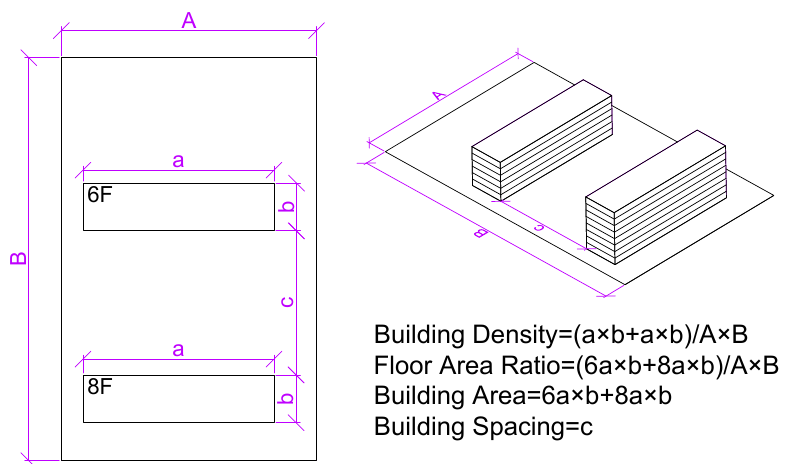
Figure 1. Indicator